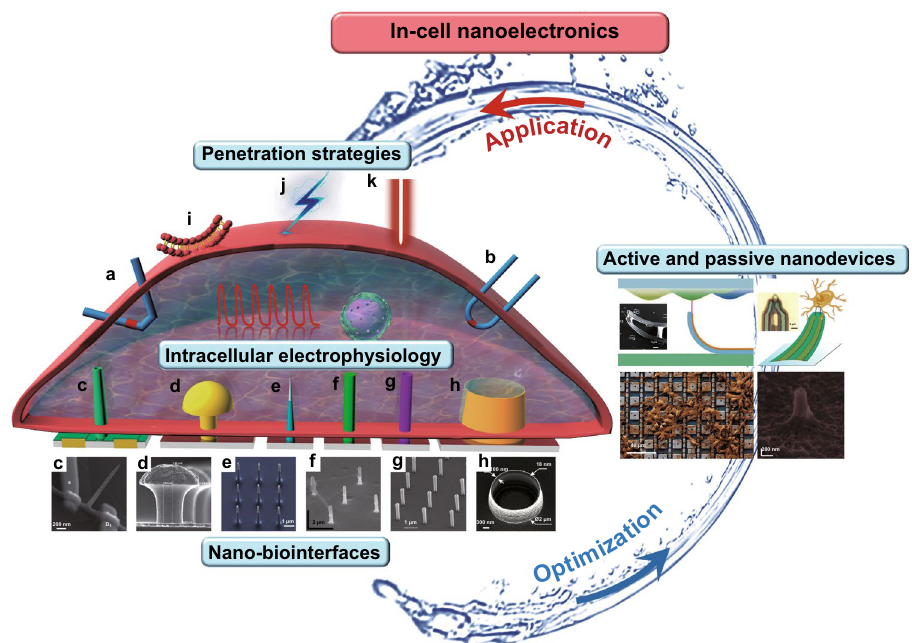
Fig. 1 In-cell nanoelectronics for opening the door to intracellular electrophysiology. In-cell nanoelectronics are developed based on the interac- tion of design optimization and practical application: the continuous optimization of nano-biointerfaces, nanodevices and penetration strategies promotes intracellular electrophysiological detection; the advantages and shortcomings reflected in the application lead to the further develop- ment of in-cell nanoelectronics. a–h Schematic illustrations and SEM or optical images of different nanodevices, including branched nanotube FET ( a ), gold-mushroom-shaped electrode ( b ), nanowire electrode ( c ), nanopillar electrode ( d ), nanotube electrode ( e ), volcano-shaped elec- trode ( f ), kinked nanowire FET ( g ), U-shaped nanowire FET ( h ). i–k Schematic illustrations of penetration strategies, including chemical modi- fication ( i ), electroporation ( j ), plasmonic optoporation ( k